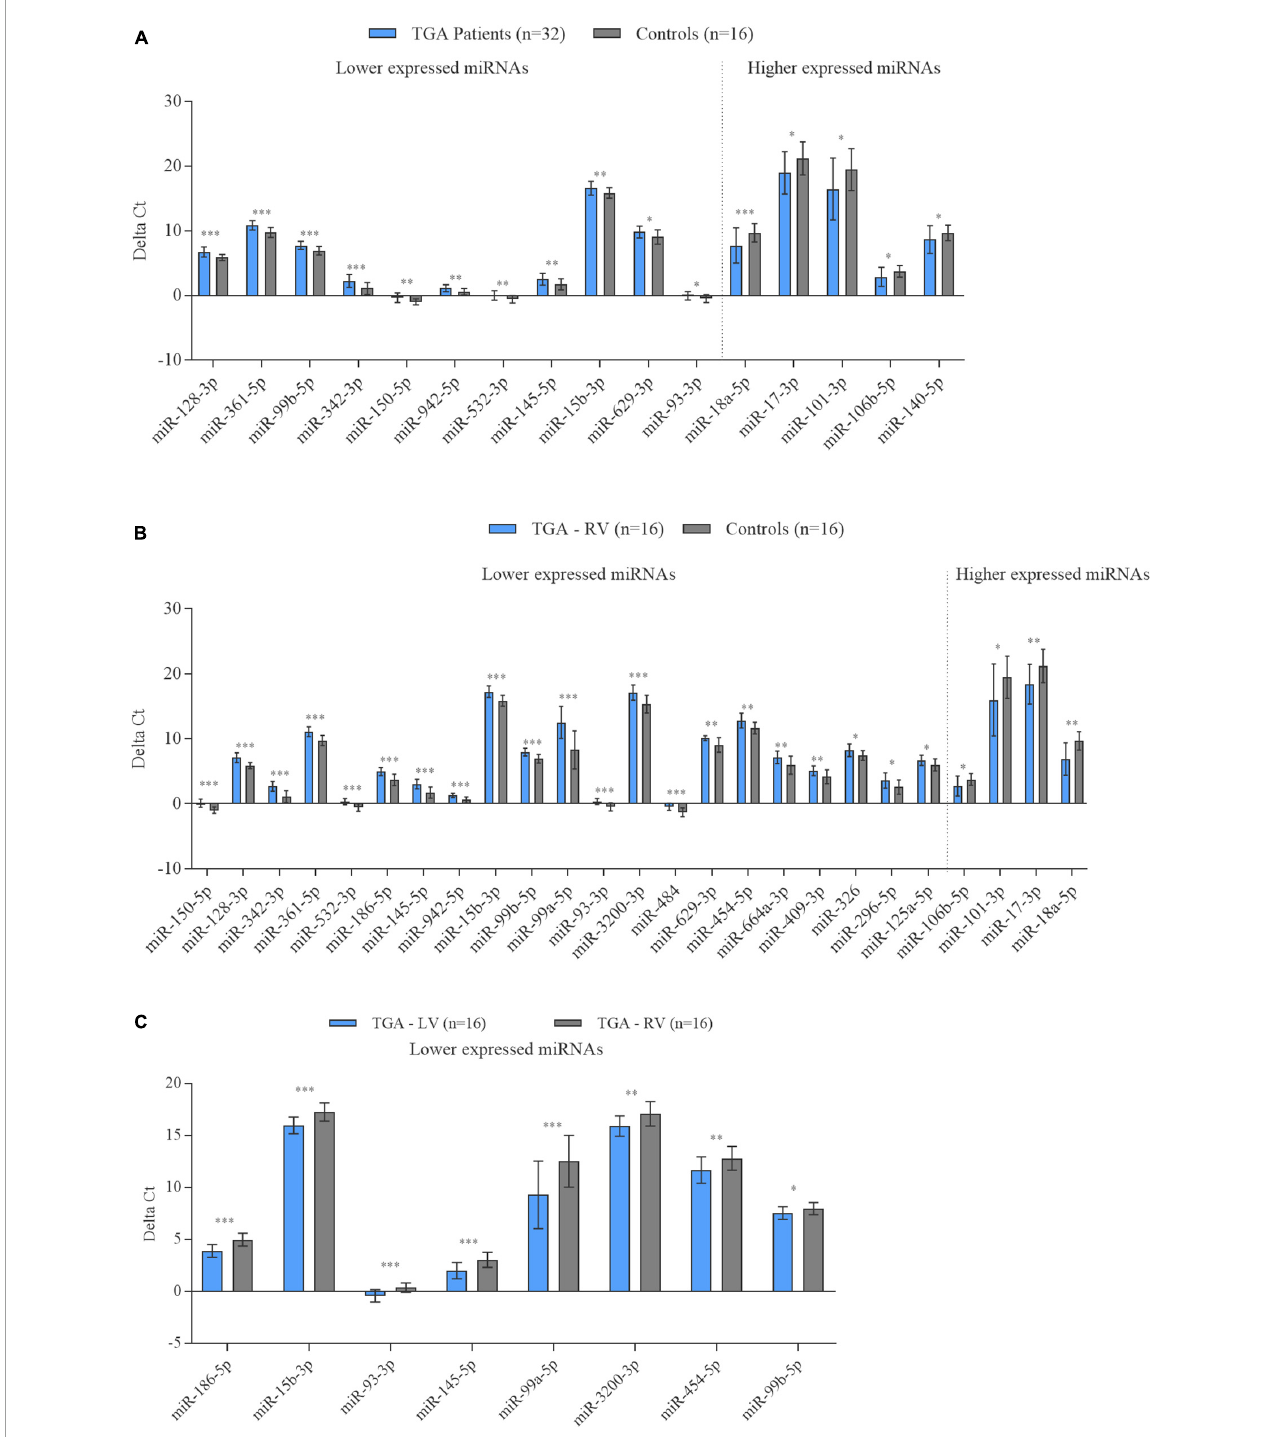
FIGURE2 Expression levels of miRNAs in the blood samples of patients with TGA (TGA-RV and TGA-LV) compared to controls determined by RT-qPCR. Data are presented as the mean (cid:49) Ct of either TGA-RV or TGA-LV and both (TGA) and matched controls (lower (cid:49) Ct, higher abundance level). RNU RNU6B was used as an endogenous control for the normalization of miRNAs, respectively. Unpaired-two-tailed t-test and mean ± SD was used to evaluate differences in expression level. P < 0.05 with FDR adjustment was considered statistically significant (* P < 0.05; ** P < 0.01; *** P < 0.001).